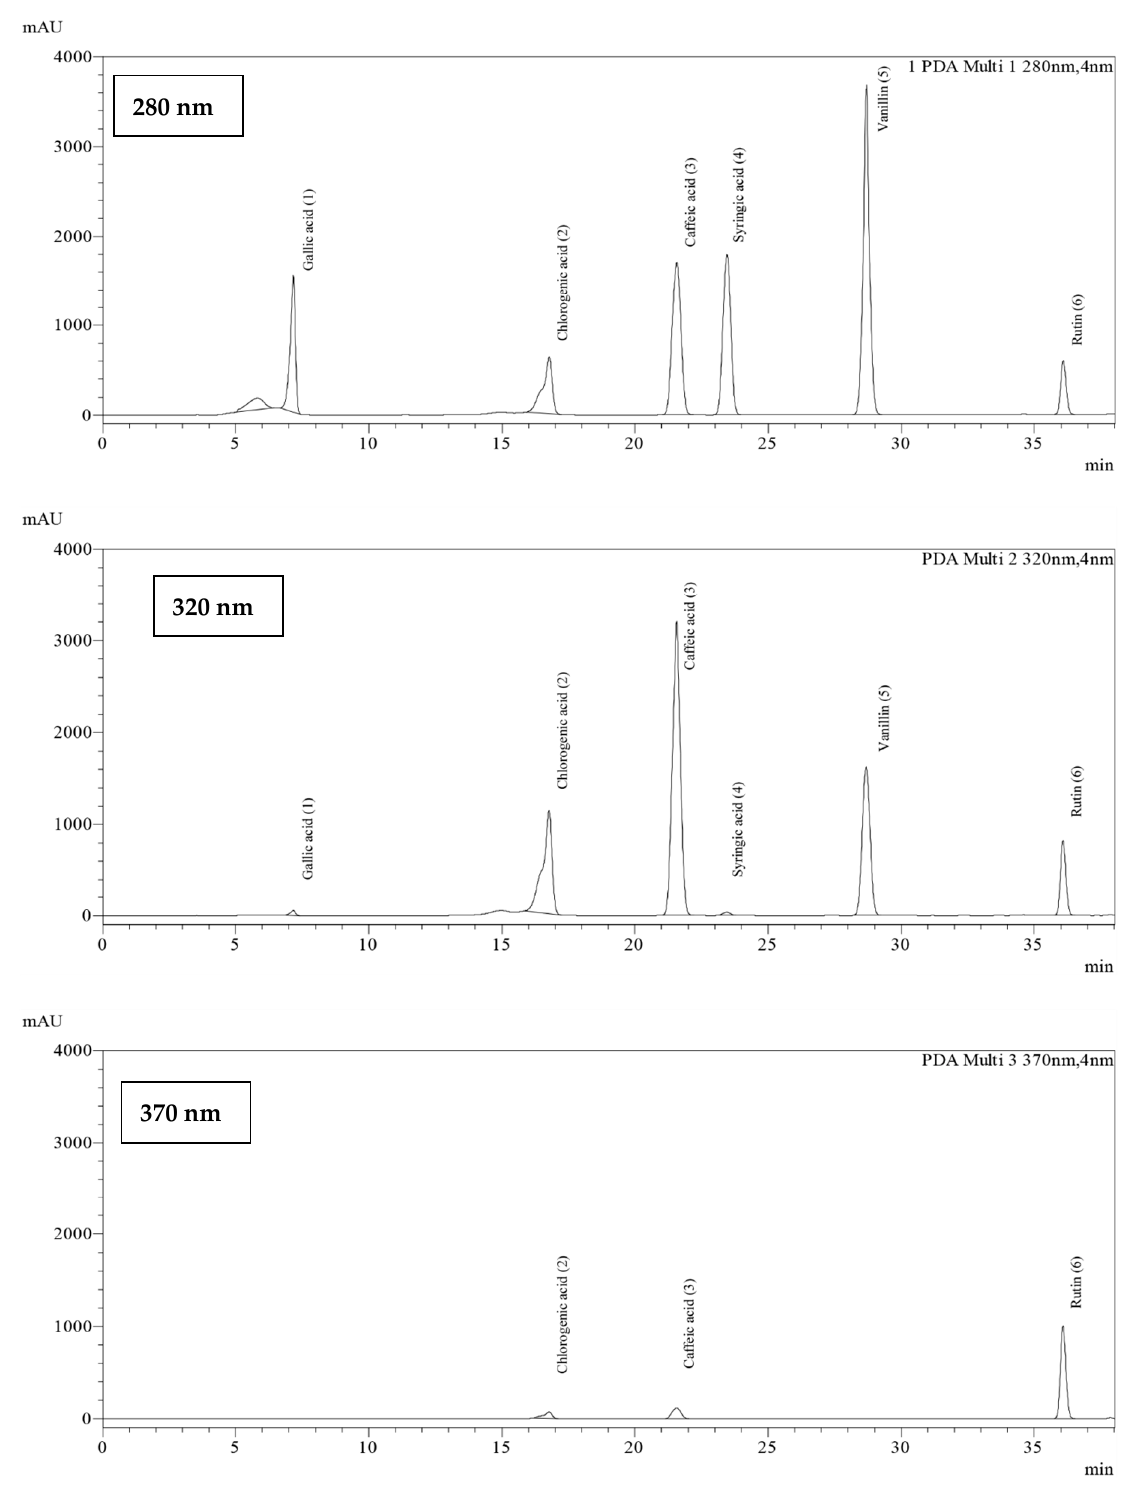
Figure 2. The HPLC chromatogram of the mixture of 6 standard phenolics and flavonoids at a final concentration of 500 µg/mL in methanol was detected at 280, 320, and 370 nm. The peaks are assigned as follows: gallic acid ( 1 ), chlorogenic acid ( 2 ), caffeic acid ( 3 ), syringic acid ( 4 ), vanillin ( 5 ), and rutin ( 6 ).